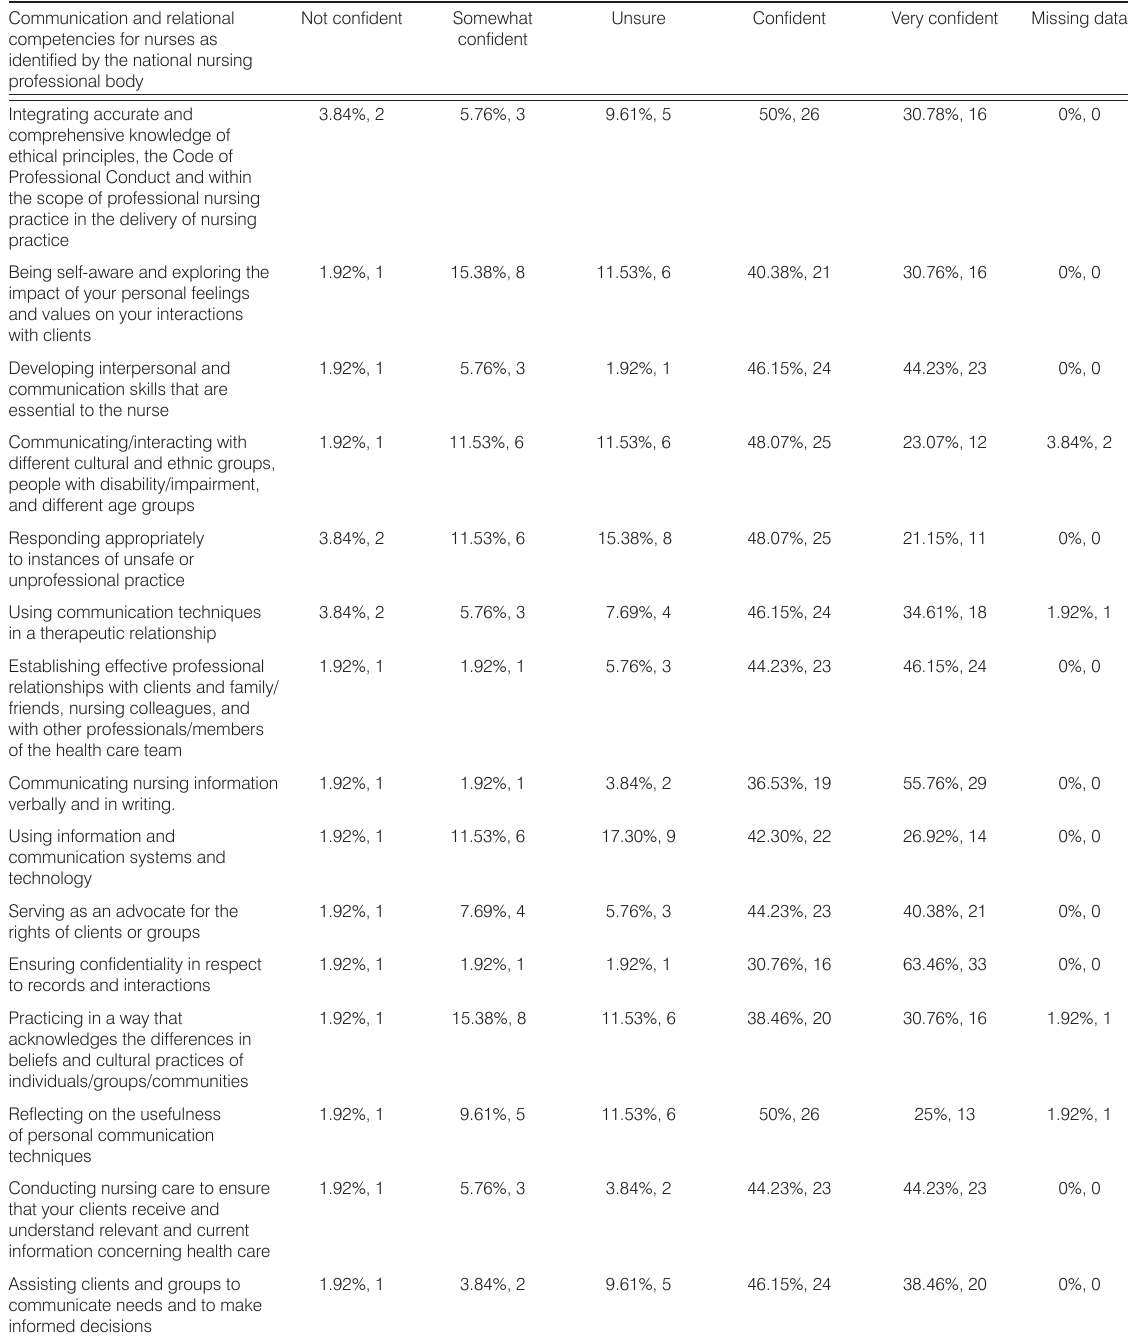
Table 1. Nurses’ confidence with communication skills competencies in nursing practice (%, n ).